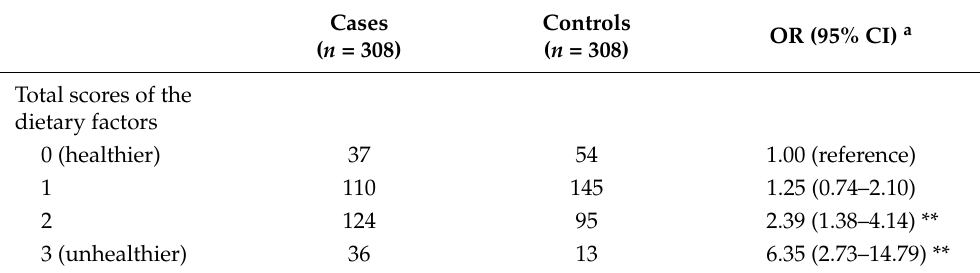
Table 5. Odds ratios (ORs) and 95% confidence intervals (95% CIs) of gastric cancer by total scores of dietary factors irritating the stomach